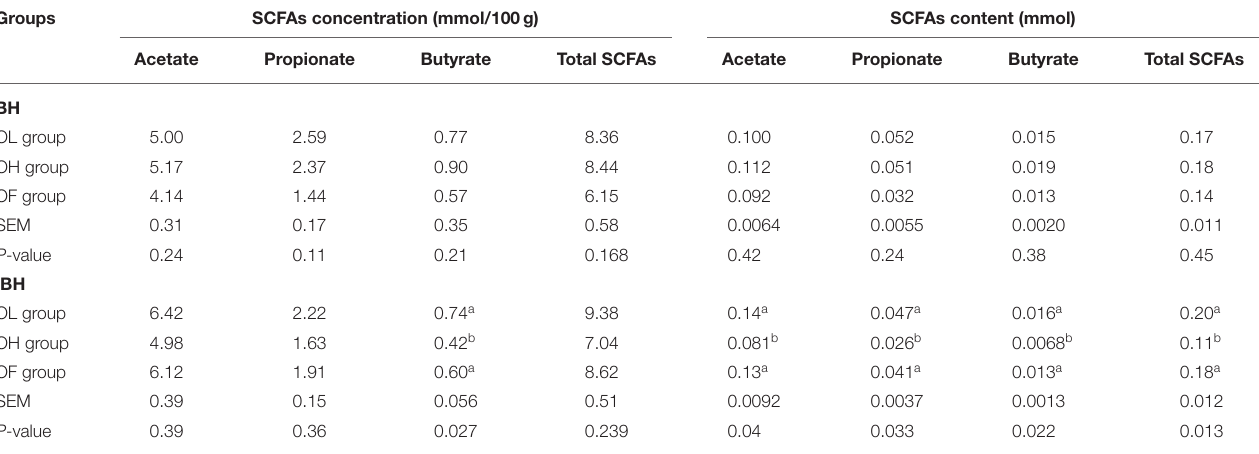
TABLE 4 | Effect of eubiotic lignocellulose on the concentration of and content of SCFAs in BH and IBH.